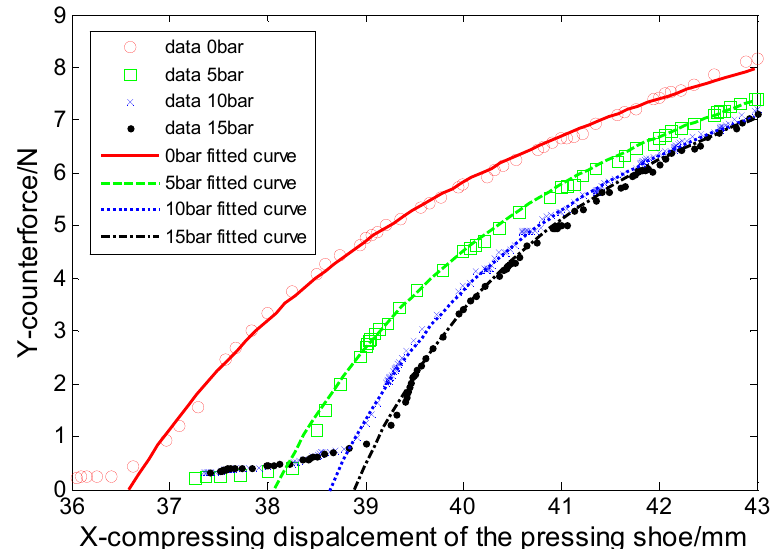
Figure 15. The influence of the pressing displacement on the in contact area of the inner hose.